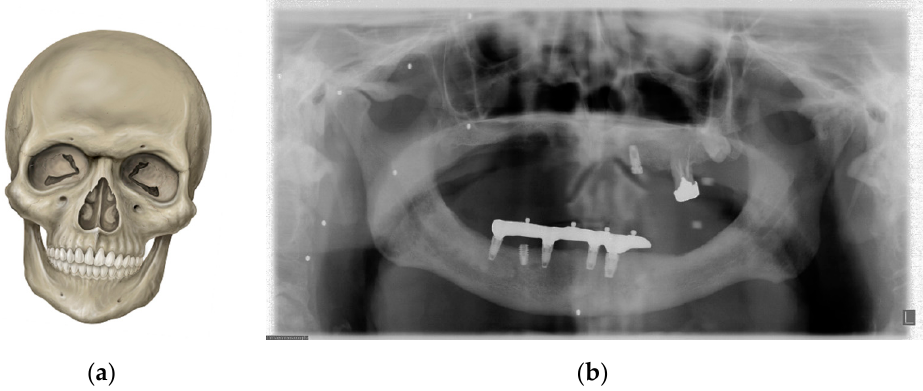
Figure 3. Tilting. Head tilt towards the left: ( a ) picture; ( b ) panoramic radiography. The left mandibular angle and condyle are in a lower position than the contralateral side. Note the punctiform metallic images on the right side due to the shotgun pellets in the soft tissue. Metal artefacts are projected into the airspace between upper and lower jaws on the left side in the form of punctiform radiopaque images.